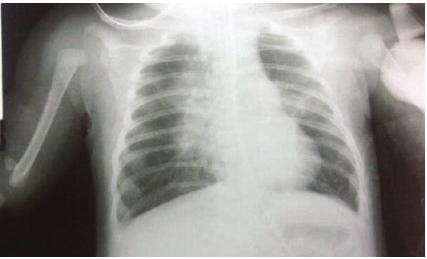
Figure 1: Anteroposterior thorax imaging showed bilateral pneu- monia and no cardiac